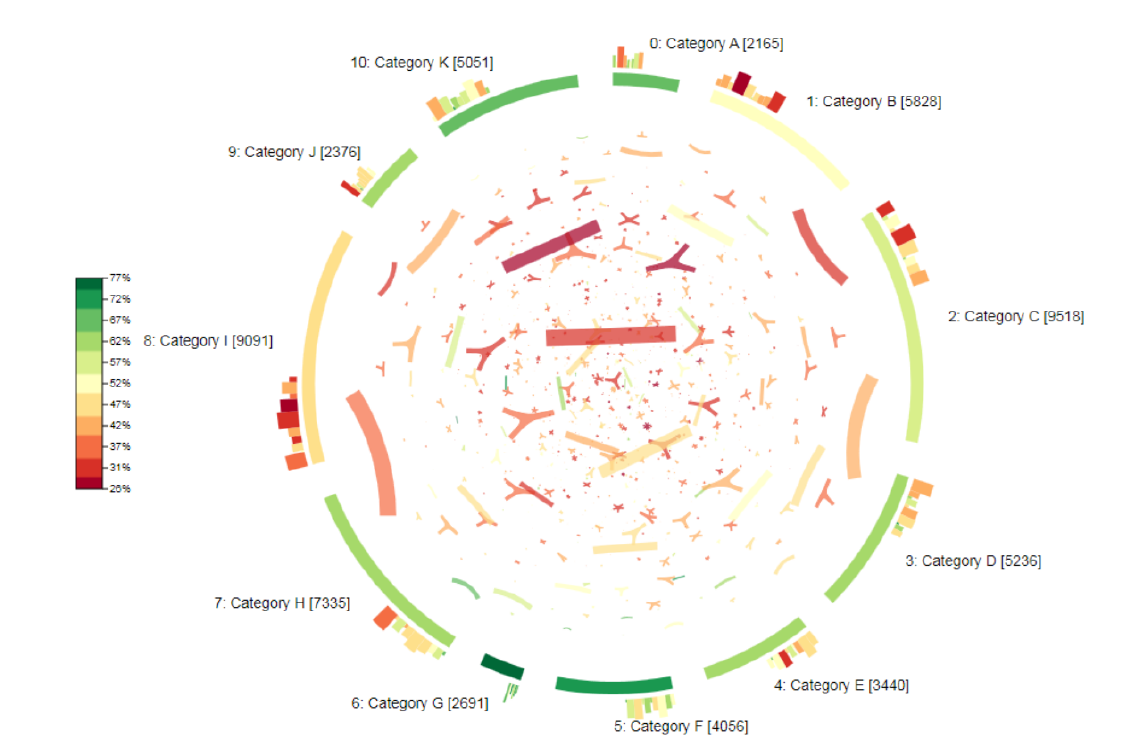
Figure 5. The extended chord diagram where glyphs are added to show the relationship between automotive component failure rates and customer satisfaction. Image courtesy of Nicholas et al.